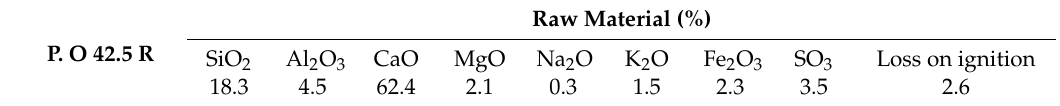
Table 1. Chemical composition of the Portland cement.